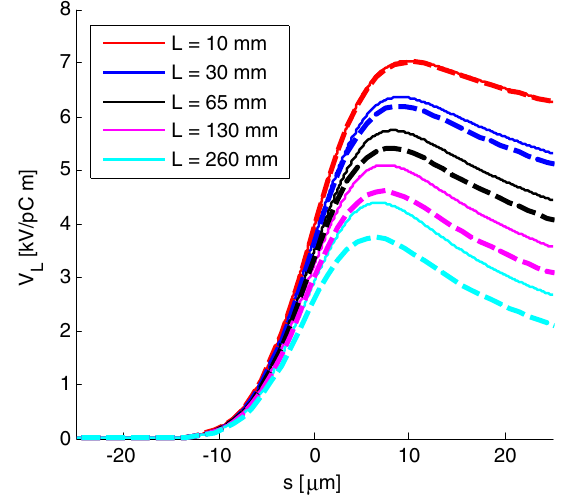
FIG. 3. Short-range longitudinal wake potentials for a bunch of ¼ 5 (cid:2) m in a periodic structure of radius a ¼ 2 mm were (cid:1) z calculated using the KB model (solid lines) and the ECHO2D code (dashed lines) for different values of the cell length (see color code in the legend). the difference between the KB model and the ECHO2D simulations for a=L (cid:5) 1 .